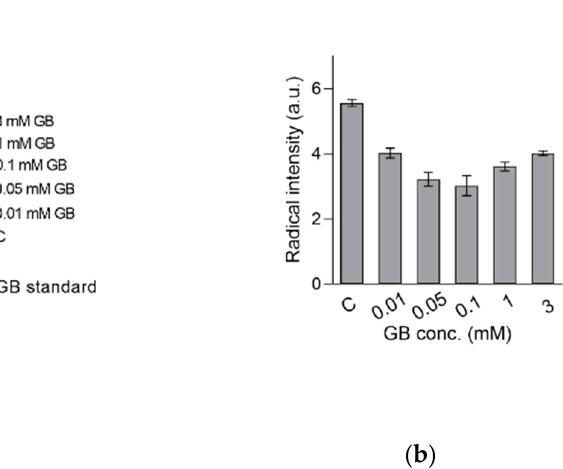
Figure 6. EPR spectra of the S. rebaudiana plants exposed to GB in concentration 0 − 3 mM and a Gd standard at 330 µ g in capillary, at room temperature, 9.46 mW power. The g -values of the signals are indicated ( a ); radical intensity of the S. rebaudiana plants exposed to GB measured by peak-to-peak difference at I 3513G –I 3527G ( b ). Table 2. Concentrations of minerals in dried, powdered samples of S. rebaudiana after exposure to 0–3 mM